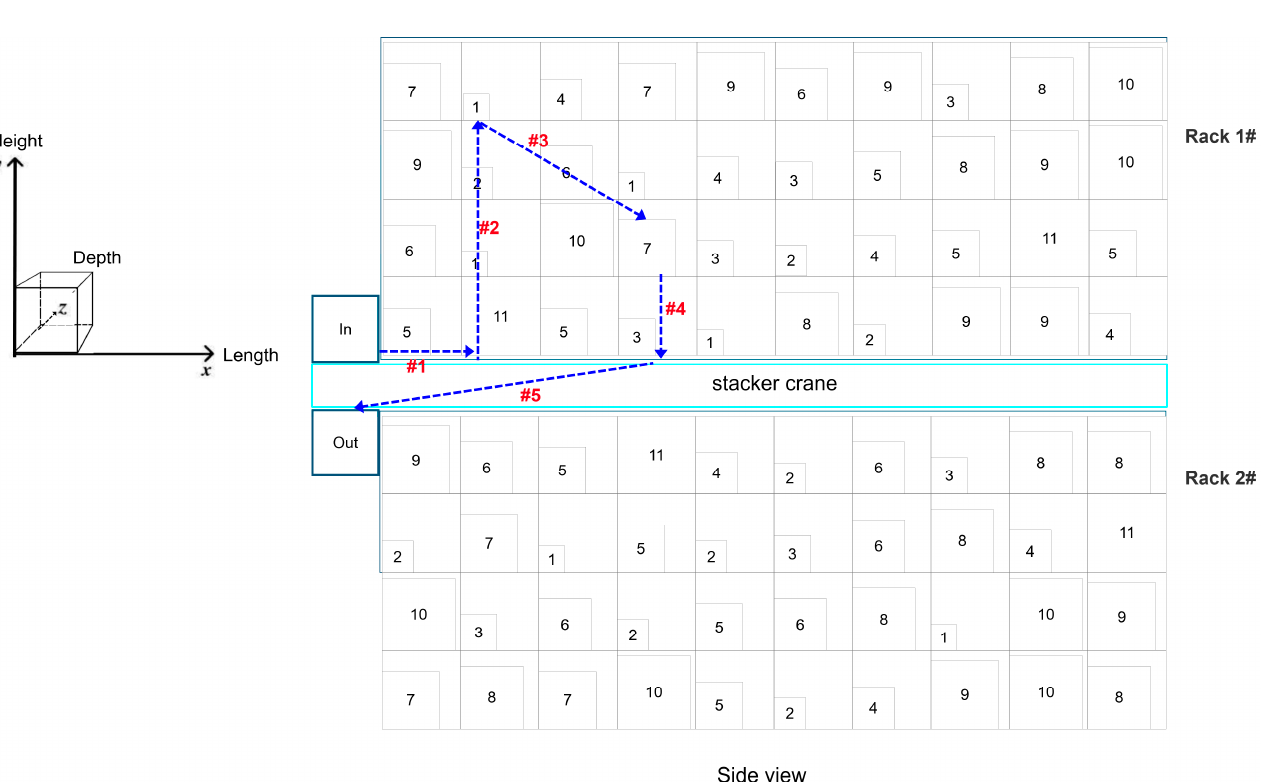
Figure 8. An example of DC in the Type A rack strategy.